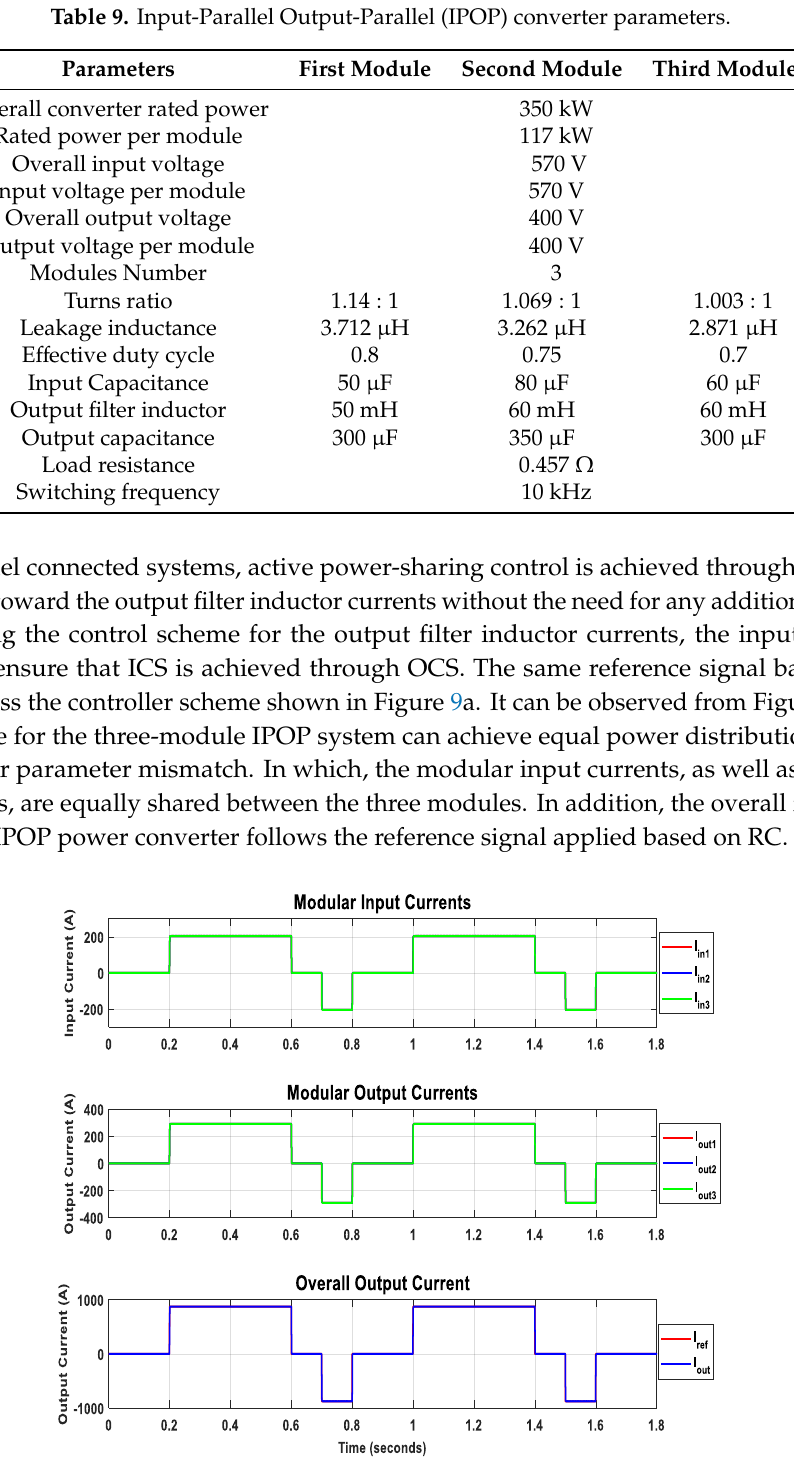
Table 10. IPOS converter parameters.